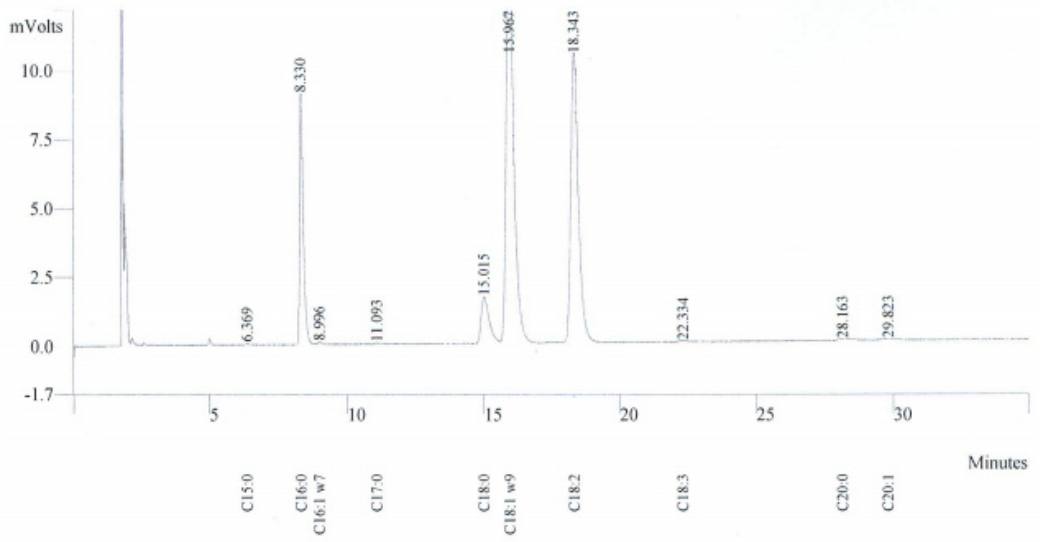
Figure 3. Gas chromatogram (GC–FID) of fatty acid methyl esters of an Argan oil sample. Linoleic acid (C18:2) content was high in samples from Safi (35.23%) followed by those from Essaouira (32.84%) and Sidi Ifni (32.12%). These provinces represent the